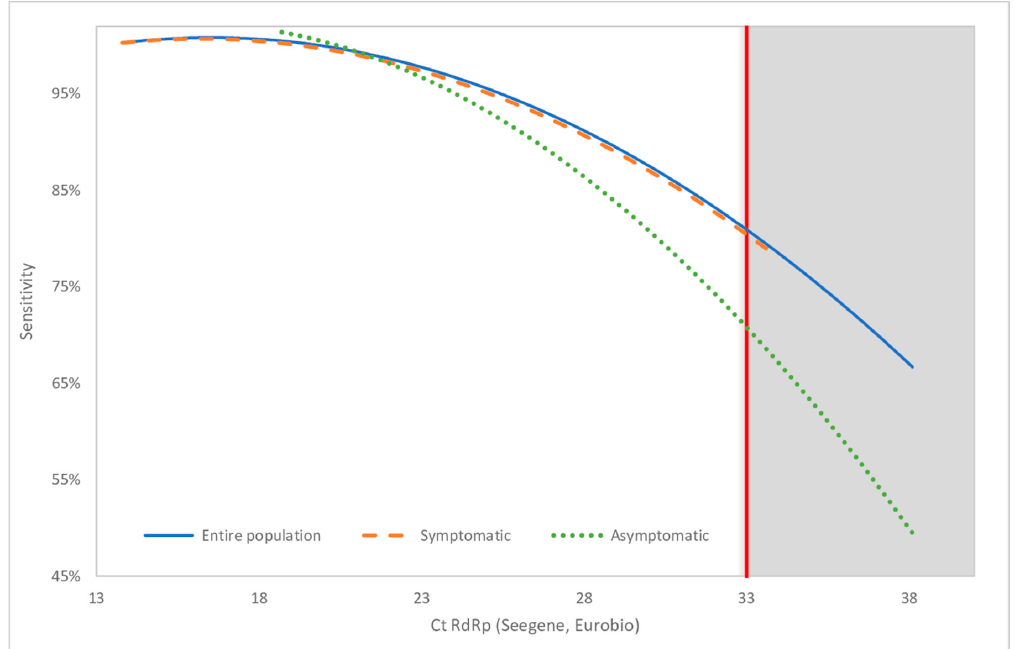
Figure 5. Evolution of sensitivity of LoopDeetect COVID-19 according to Ct RdRp values. Allplex 2019 n-Cov assay kit (Seegene, Korea) was the gold standard for calculation of sensitivity. The blue, red and green curves represent the entire, symptomatic and asymptomatic populations, respectively. The red vertical line indicates the threshold Ct = 33.